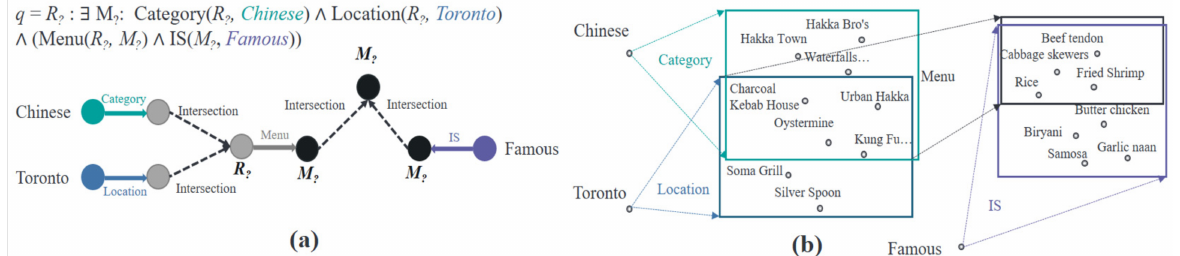
Figure 1. FOL query and its ( a ) computation graph and ( b ) vector space representation for a domain specific natural query “ Which famous dishes Chinese restaurants serves in Toronto?